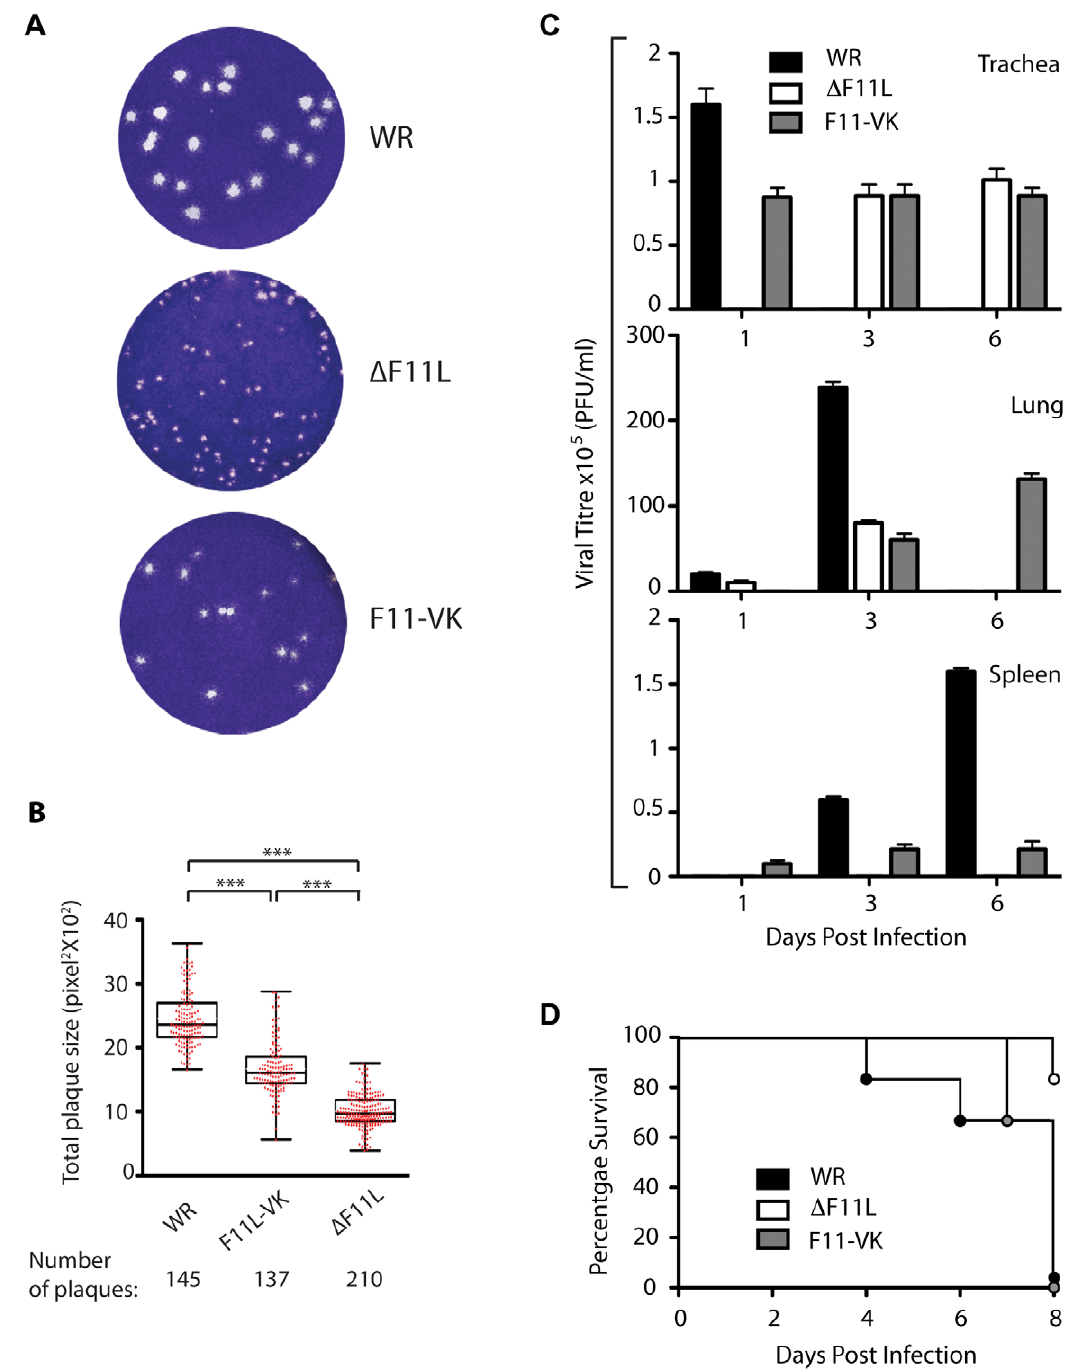
Figure 5. Loss of F11 limits spread of infection in vitro and in vivo. ( A ) Representative images of plaques formed by WR, D F11L and F11-VK at 4 days post infection. ( B ) Quantitative analysis of the size of plaques formed by WR, D F11L and F11-VK are shown as Box-and-whisker plots overlaid with the data points (red). The boxes represent 25th and 75th percentile of the data, the line bisecting the box represents the median and *** indicates P , 0.001. ( C ) Quantitative analysis of viral titres in the trachea, lungs and spleens of WR (black bars), D F11L (white bars) or F11-VK (grey bars) infected mice at 1, 3 and 6 days post inoculation. Error bars indicate SEM from five mice and the minimum limit of detection is 100 pfu/g tissue. ( D ) Survival rates of C57/BL6 mice infected intra-nasally with 5 6 10 6 pfu of WR, D F11L and F11-VK viruses (n=6). doi:10.1371/journal.pone.0008506.g005 To quantify the extent of virus spread in vivo we performed C57BL6 mice intranasally with 5 6 10 6 plaque-forming units of plaque assays on trachea, lung and spleen extracts 1, 3 and 6 days purified WR, D F11L or F11-VK viruses. Intranasal innoculation of after intranasal inoculation. We found that high titres of WR were WR results in an acute infection of the lung followed by subsequent detected in the trachea of animals one day post inoculation spread of extra-cellular virus to the visceral organs of the mouse [33].